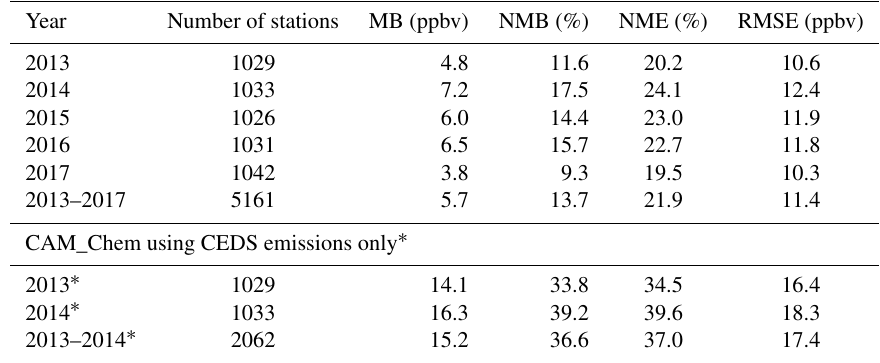
Table 3. As Table 2 but for annual MDA8 O 3 , with mean bias (MB, ppbv), normalized mean bias (NMB, %), normalized mean error (NME, %), and root-mean-square error (RMSE,